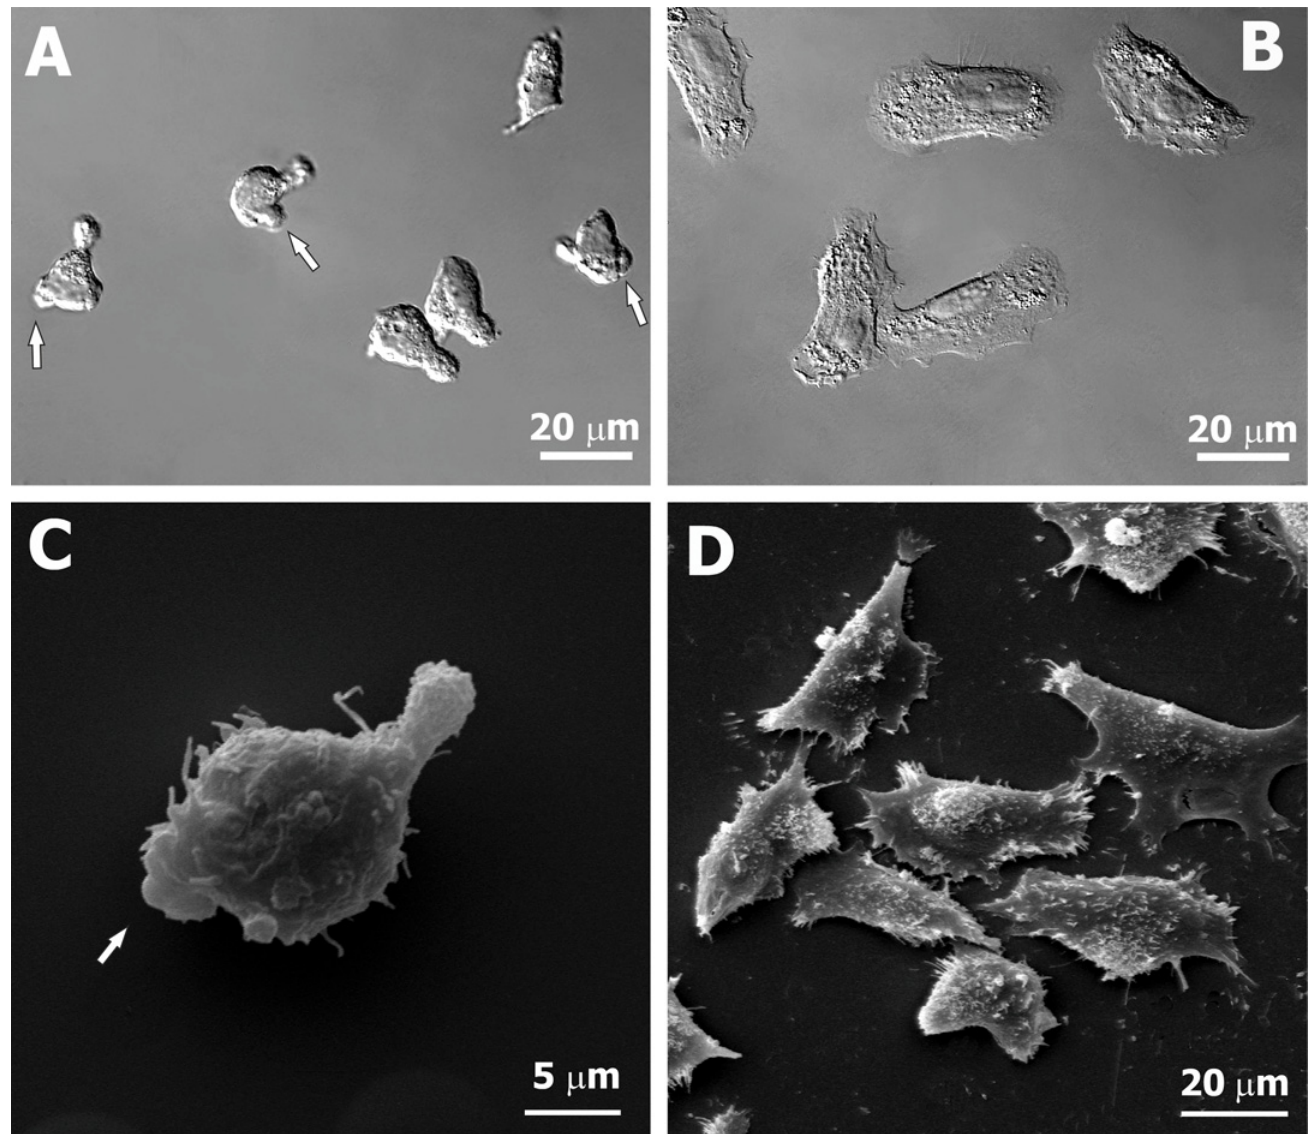
Fig 1. The morphology of two sublines of Walker carcinosarcoma WC 256 cells migrating in an adhesive mode but forming different protrusions. (A, C) Weakly adherent cells forming blebs spontaneously (BC); (B, D) Strongly adherent cells forming lamellipodia (LC); photographs obtained in DIC optics (A, B) or in SEM (C, D). Arrows indicate blebs at the leading edges of